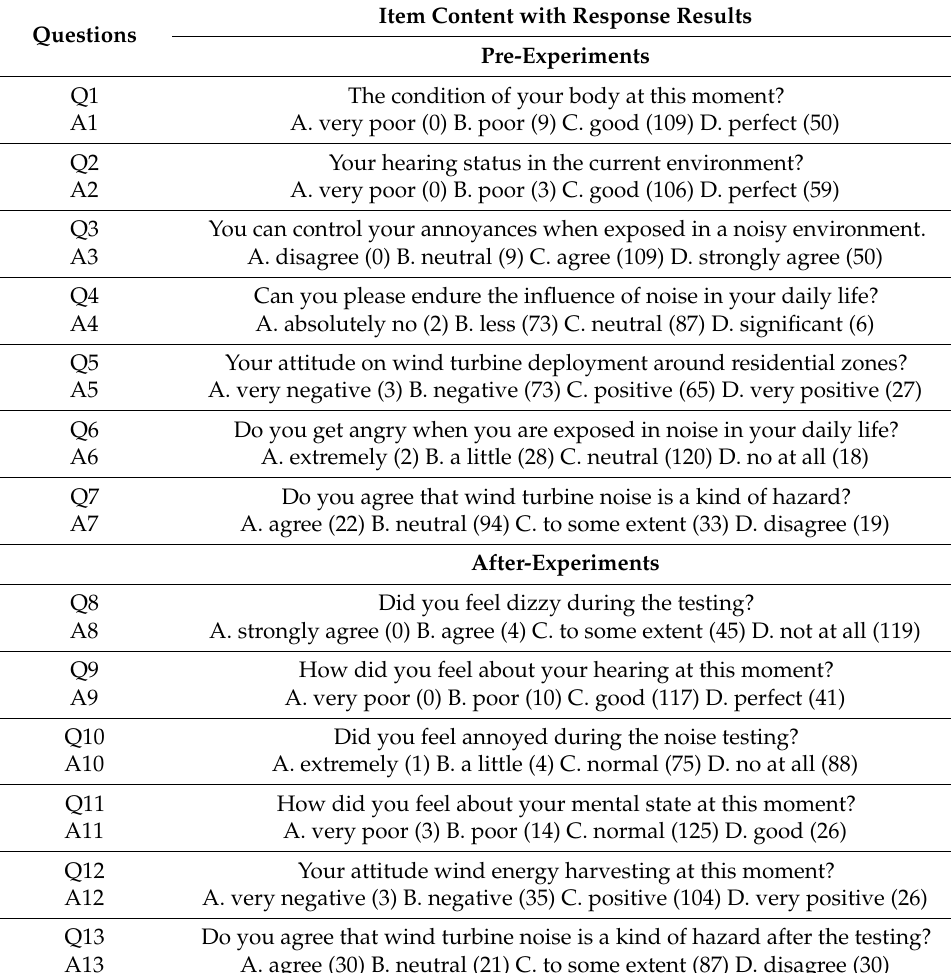
Table A1. Questionnaire survey of people’s influence on wind